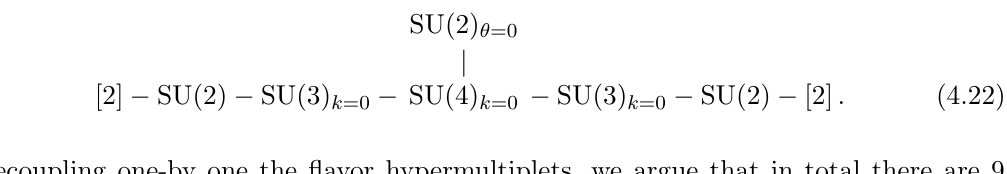
match those that have a quiver gauge theory description with the associated weakly-coupled